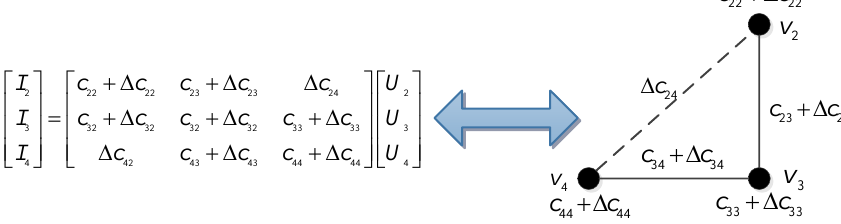
Figure 3. The relation between coefficient matrix and contracted